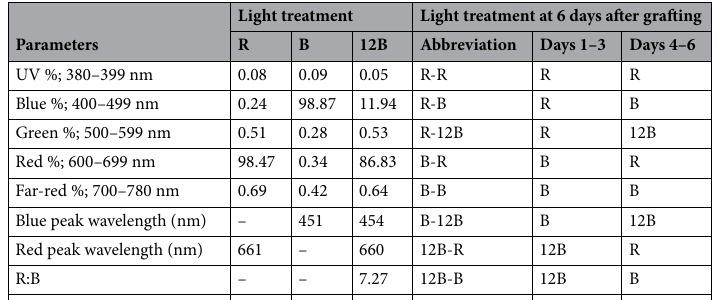
Table 1. Spectral parameters of the three light treatments tested and abbreviated names of trays from each light treatment switching places with trays from the other two light treatments for days 4–6 after grafting.